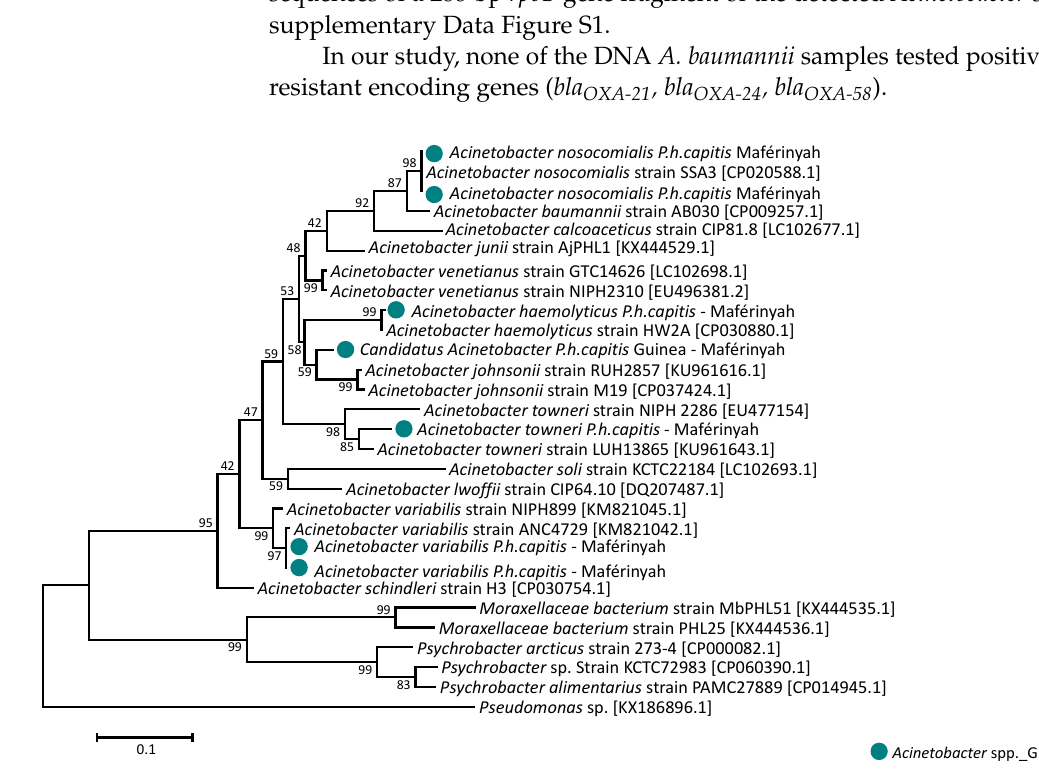
Figure 5. Phylogenetic tree highlighting the position of the Acinetobacter species identified in the head lice collected from Guinea compared to Acinetobacter spp. available in the GenBank database. Phylogenetic inferences were conducted in MEGA 7 using the maximum likelihood method based on the Kimura 2-parameter model for nucleotide sequences. Statistical support for internal branches of the tree was evaluated by bootstrapping with 1000 replicates. There was a total of 7 positions in the final